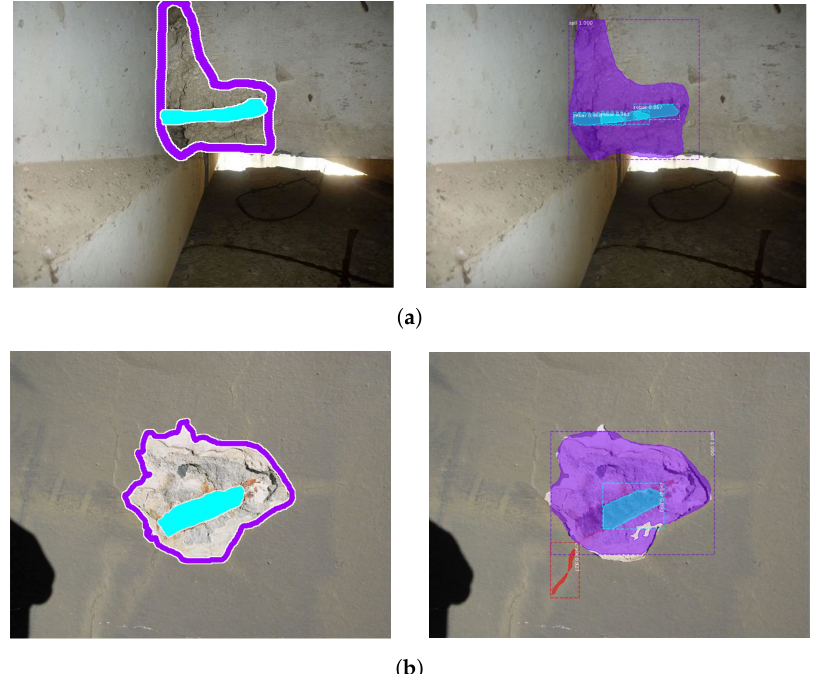
Figure 7. Examples of spalling and rebar exposure detection results (left column: original images with ground truth, right column: detection result of trained Mask R-CNN): ( a ) detection result of Spalling/Rebar-1 in Table 1, and ( b ) detection result of Spalling/Rebar-5 in Table 1.